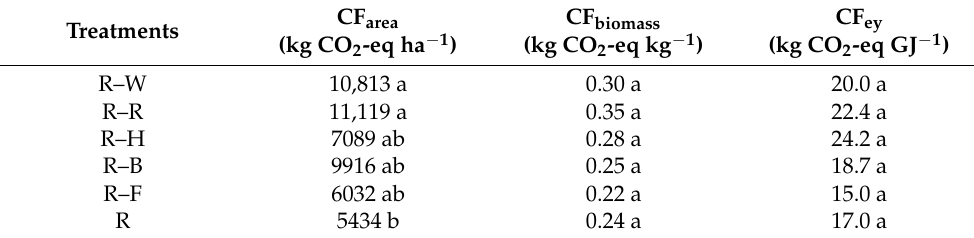
Values are mean of three replicates ( n = 3) and are annual mean values during the experimental period. Different lowercase letters in one column indicate significant difference among treatments Table 4. Effects of rice-based cropping systems on the carbon footprint.